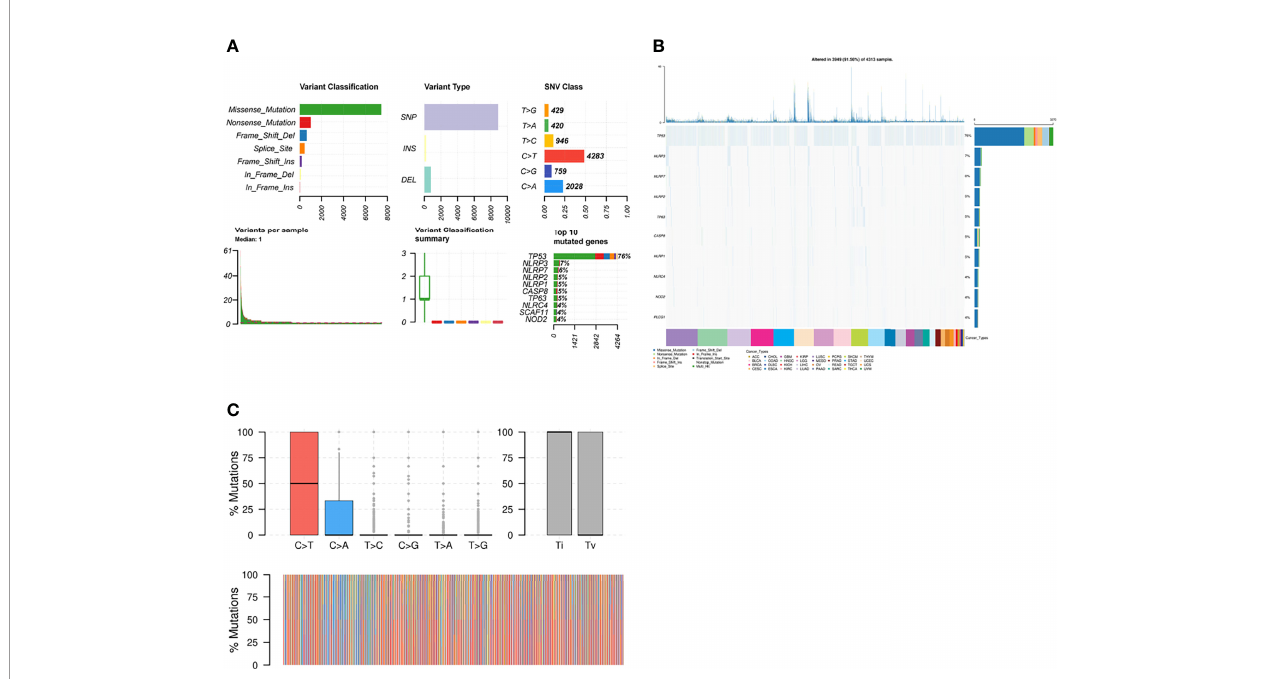
FIGURE 4 | (A) Figure summarizing the SNV classes of necroptosis gene set in pan-cancers. (B) Oncoplot of SNVs of top 10 mutated genes from the gene set of speci fi c cancers. (C) Transition (Ti) and transversion (Tv) classi fi cation of the SNVs of necroptosis genes in pan